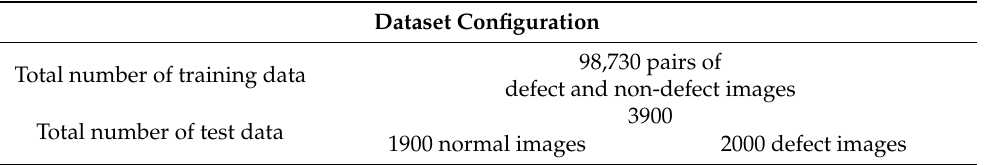
Table 5. The dataset configuration. The training data are for the autoencoders, whereas the test data are for the defect existence classification